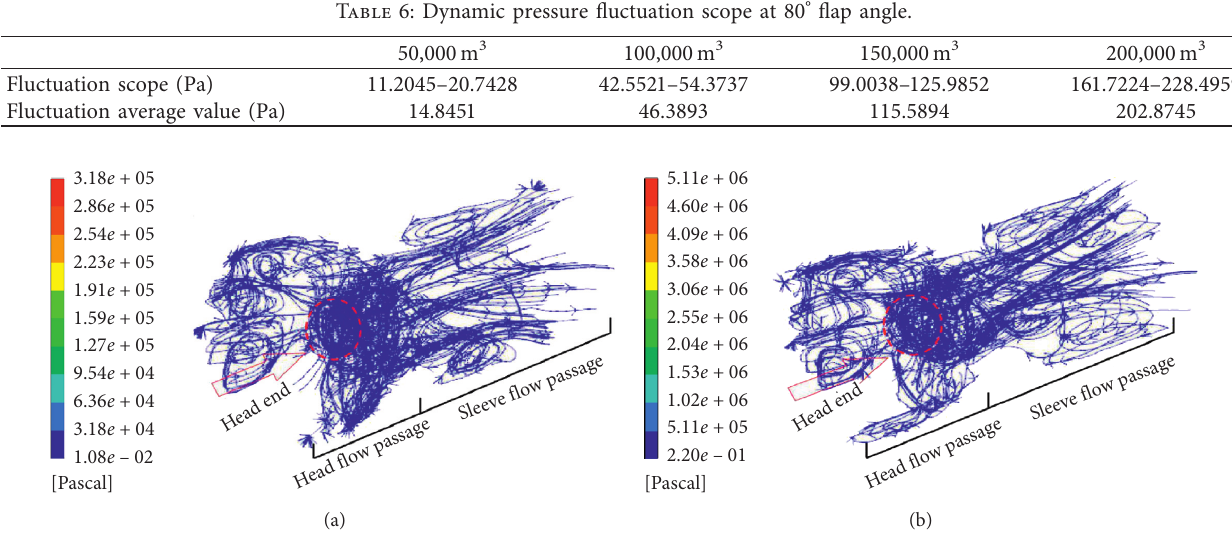
Figure 11: Head end trace diagram at 10 ° flap angle. (a) 50,000m 3 . (b) 200,000 m 3 .